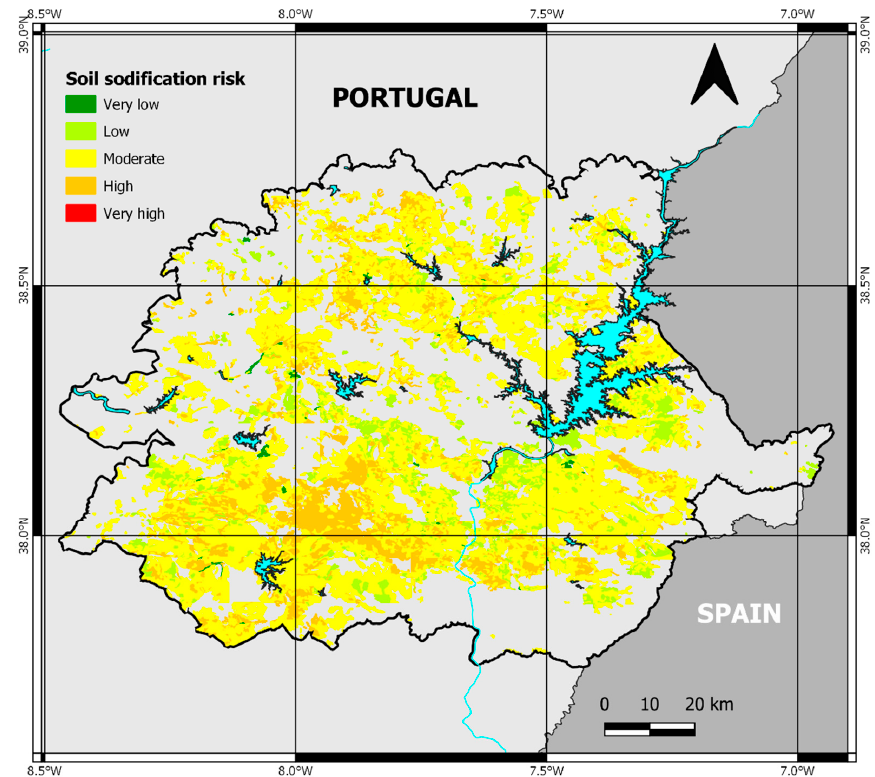
Figure 9. Sodification risk of the potentially irrigated area in the Inland Alentejo region based on the Sodification Risk index (RSO). Very Low risk: RSO < 8; Low risk: 8 ≤ RSO ≥ 12; Moderate risk: 13 ≤